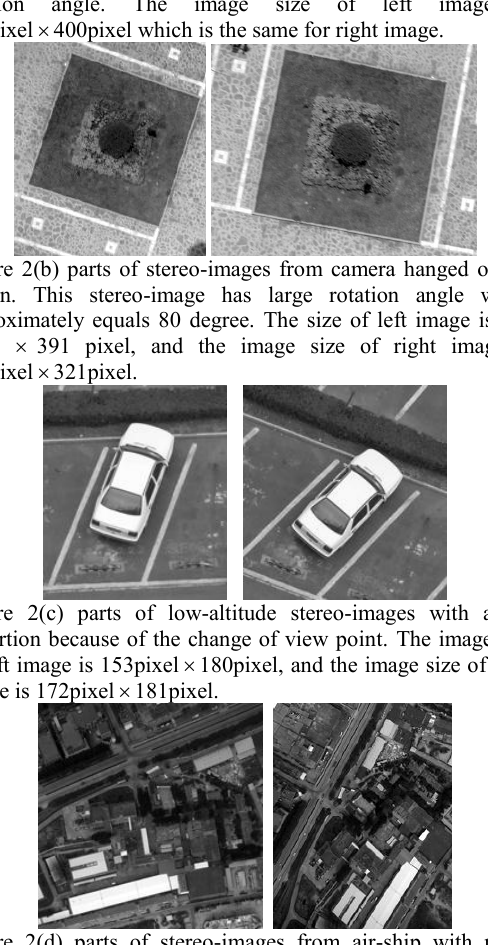
Figure 2(d) parts of stereo-images from air-ship with none- linear distortion due to the changes of rotation angle and pitch angle. The size of left image is 200pixel  201pixel, and the size of right image is 200pixel  254pixel.